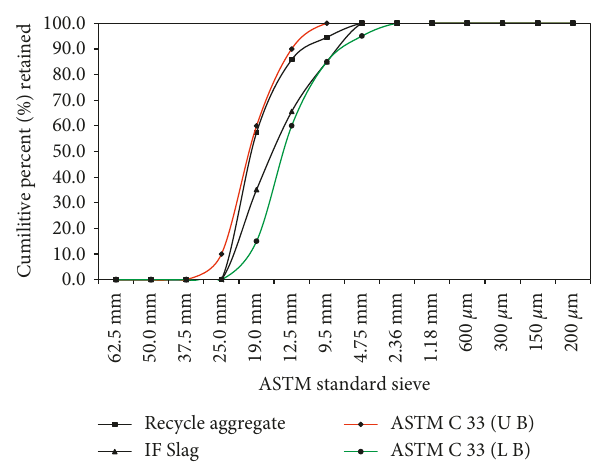
Figure 5: Sieving of IF slag using standard